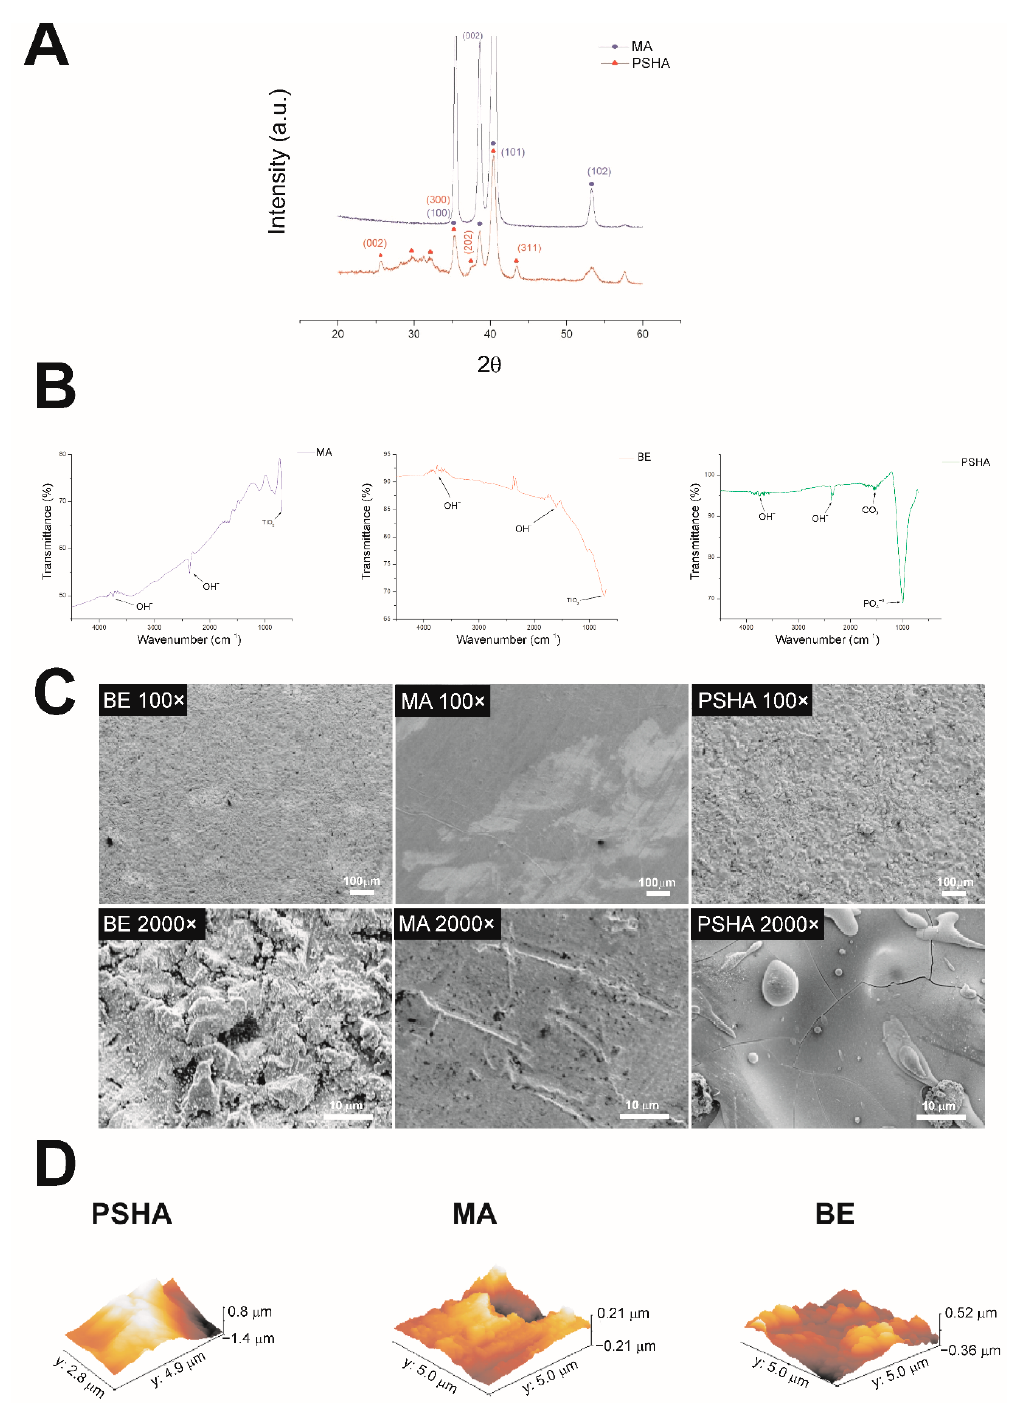
Figure 1. Surface analysis of the tested titanium samples. ( A ) XRD diffractogram of MA (blue) and PSHA (red) sample surfaces. ( B ) FTIR of machined surfaces (MA), sandblasting and etching (BE) and HA plasma spray (PSHA). ( C ) Electron micrographs of titanium surfaces with the three different types of treatment at two magnifications. ( D ) Atomic Force Microscope 3D views of the titanium surfaces.